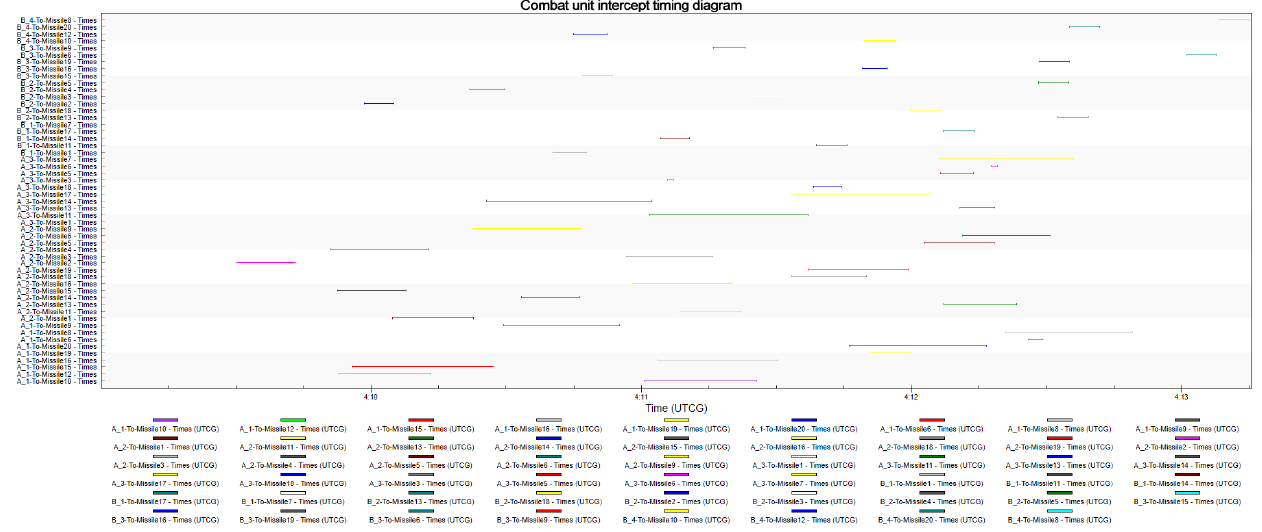
Figure 5. 3D schematic diagram of operational scenarios. Firstly, preprocess the data to obtain the intercept sequence of the combat unit to the incoming target, the result is shown in Figure 6.